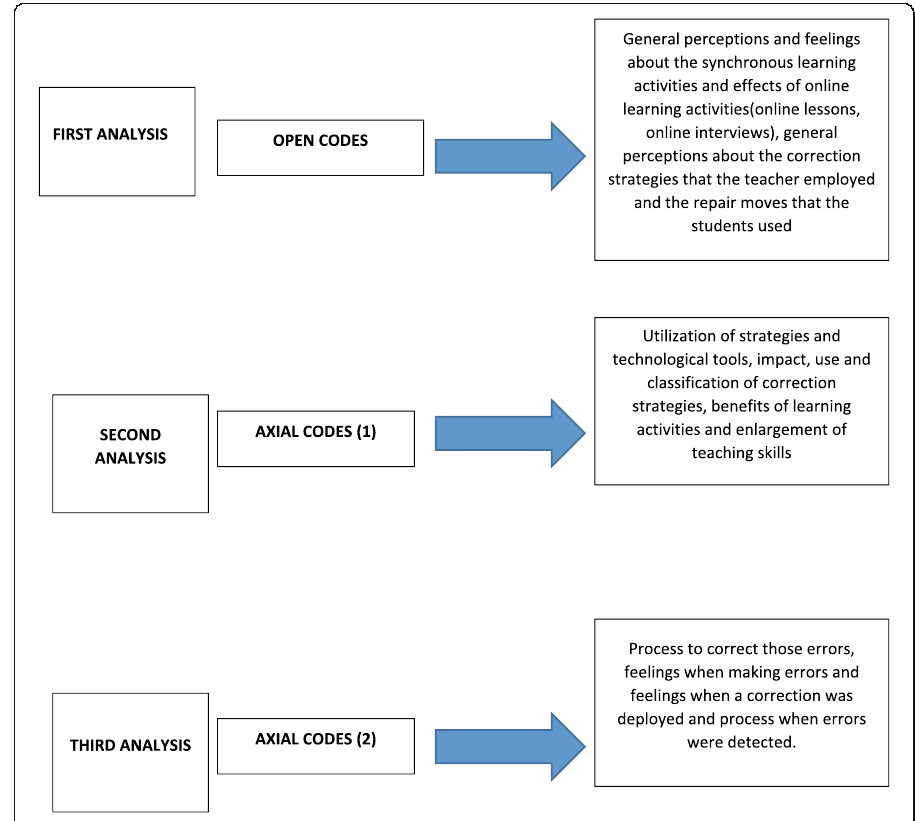
Fig. 3 Analysis of the in-depth interviews and the focus